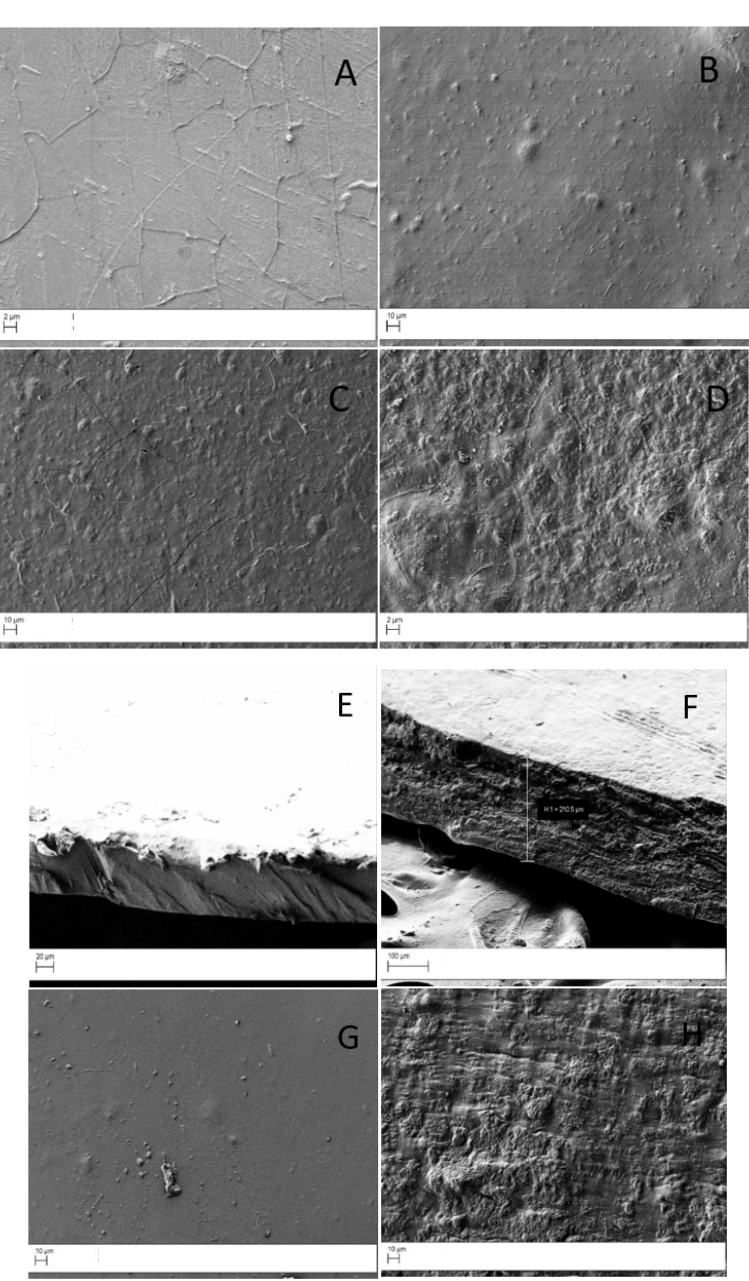
(Figure 2F), with GO sheets enwrapped by CS.